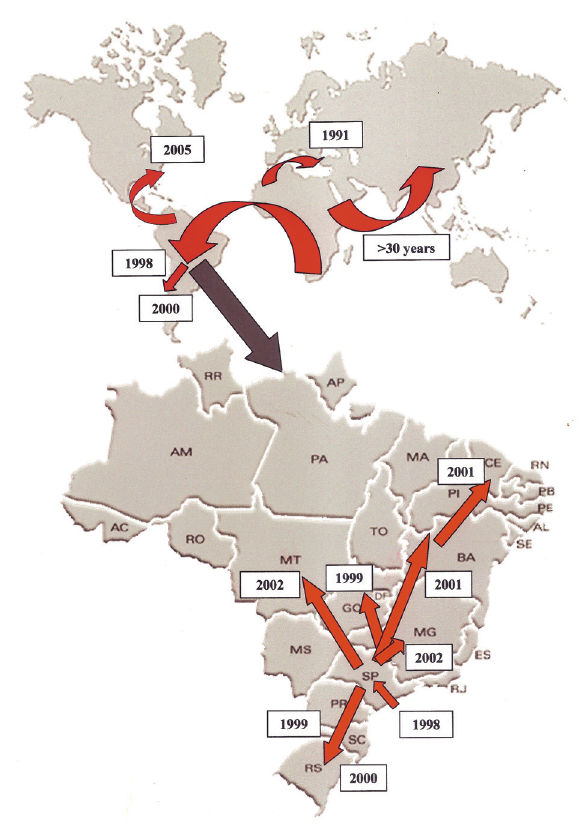
Figure 1 - Migration routes for Z. indianus involved in its dispersal throughout the world, based on studies cited in the text. The process that occurred in Brazil is